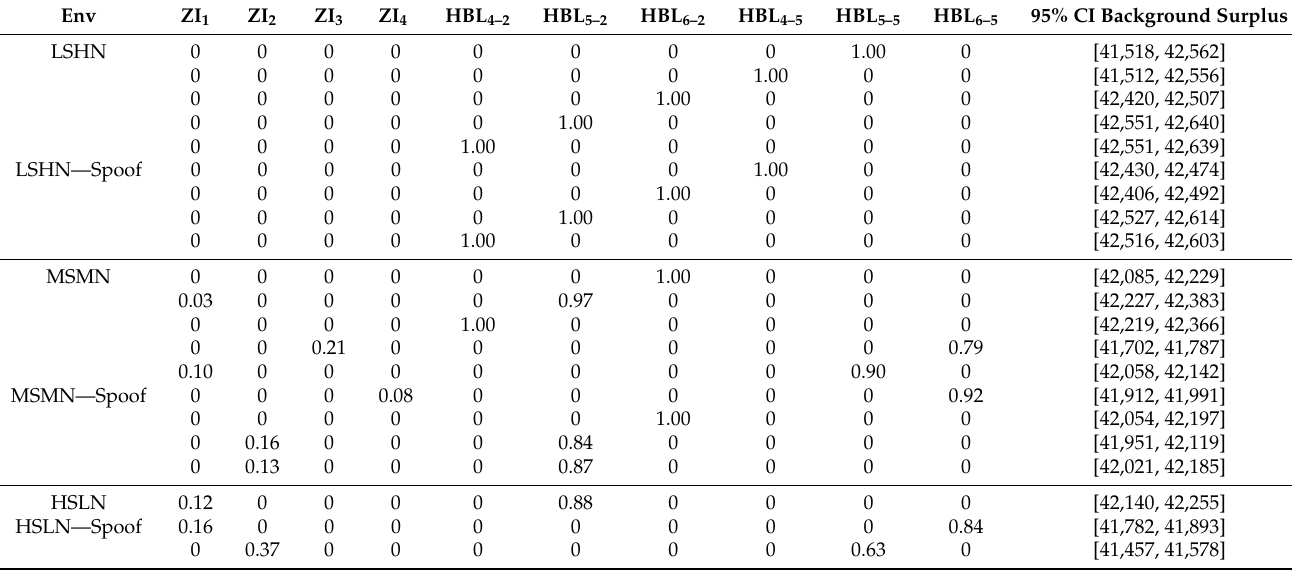
Table A19. Equilibria for games where the learning-based trading strategy set is comprised of standard HBL and HBL with price offsets. Each row describes an equilibrium found for the game described by the Env column, detailing the adoption rate of each strategy considered and the corresponding background surplus.